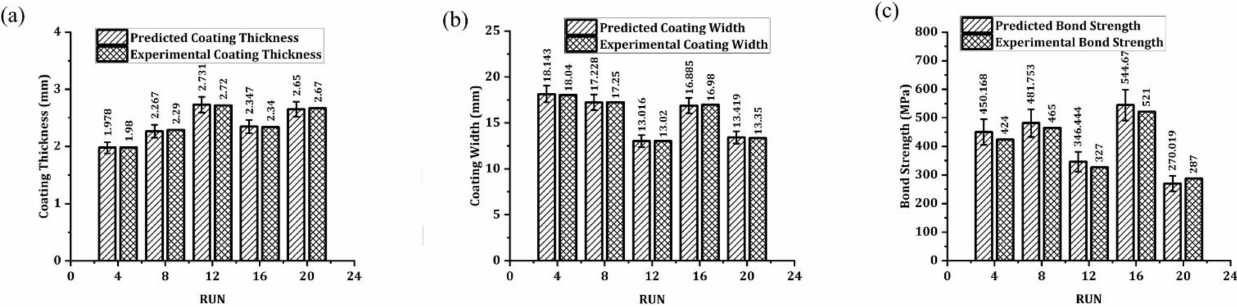
Figure 14. Additivity test results illustrating the predicted value and the experimental value for ( a ) coating thickness, ( b ) coating width, and ( c ) bond